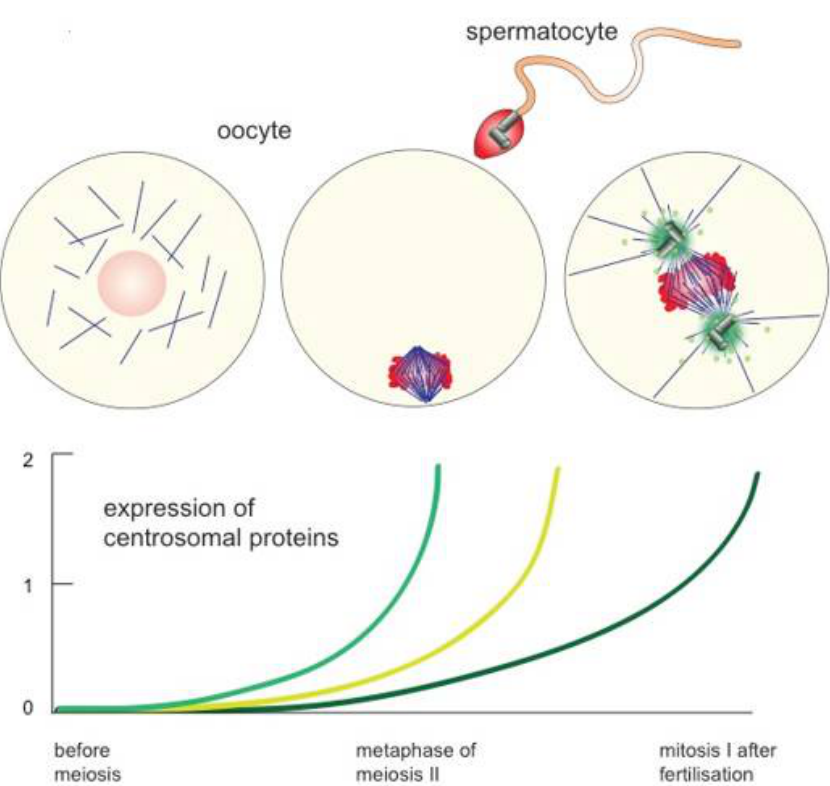
Figure 2. Re-assembly of zygotic centrosomes. Metazoan oocytes lose their centrosomes regularly before meiosis but rebuild them only after fertilisation. Oocytes use the sperm-derived basal body as a platform for the first centrosome assembly and restart the expression of centrosomal proteins (see coloured lines in graph) to allow on-going centrosome replication afterwards. Female meiosis, however, occurs in most metazoan species in the absence of centrosomes.